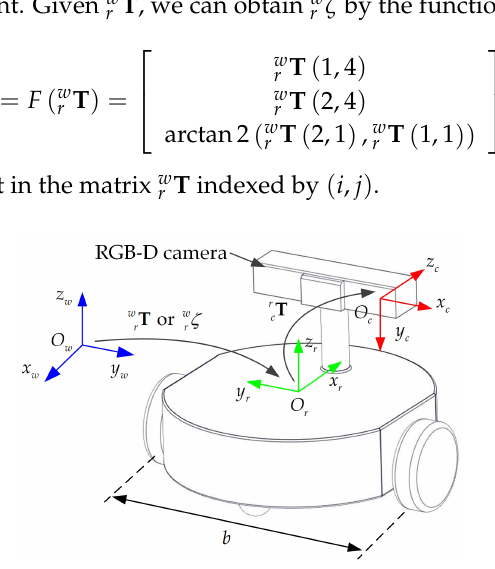
Figure 1. Differential-drive robot equipped with an RGB-D